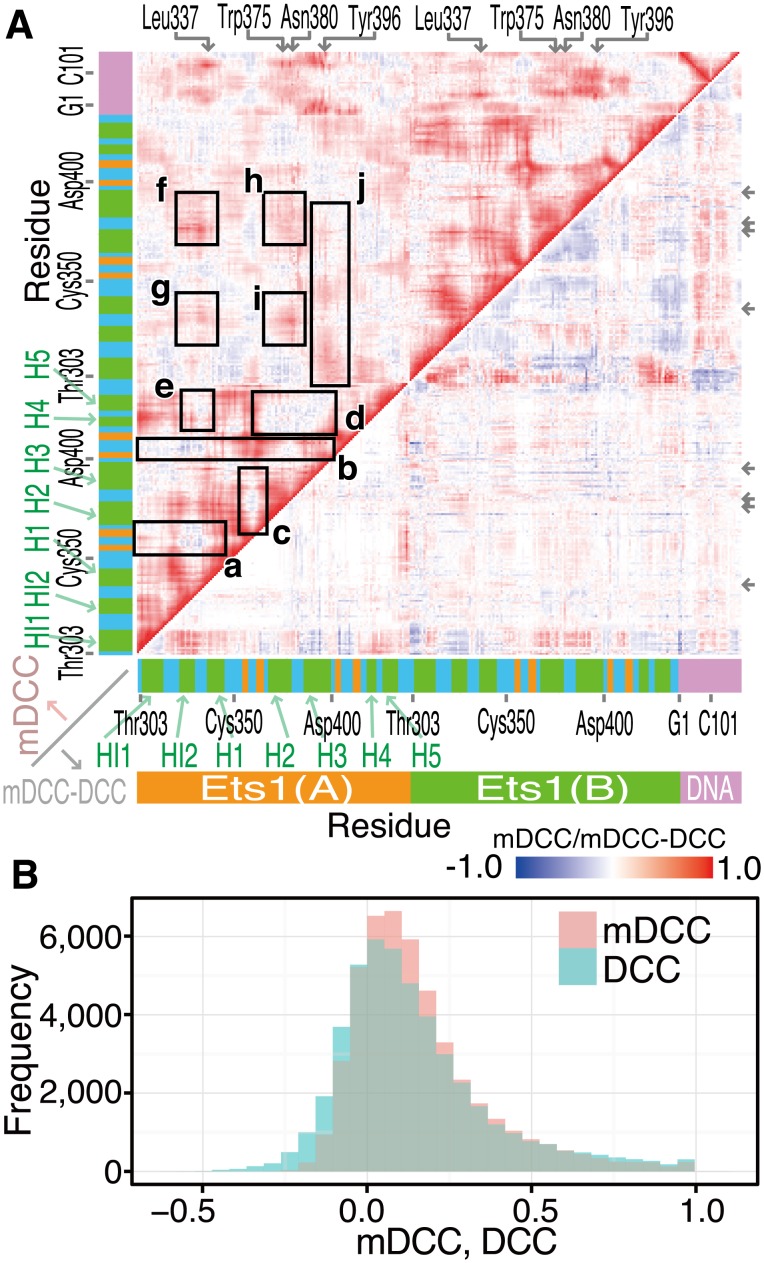
mDCC and DCC among residues of the (Ets1)2–DNA complex.(A) The maps of mDCC values and their differences from the DCC values (the upper and lower triangles, respectively). The color gradation from blue to red corresponds to mDCC values and their differences from DCC values from −1.0 to 1.0. The horizontal and vertical axes denote residues in the system, including two Ets1 molecules and a double-stranded DNA. The colored bars along each axis provided a guide for the secondary structures of residues: green, orange, cyan, and pink denote α-helix, β-strand, loop or turn, and DNA, respectively. Parts marked by the rectangles a–j, and residues marked at the top and right of the map are discussed in the main text. (B) Histogram of residue-wise mDCC and DCC values, shown in pink and cyan, respectively.